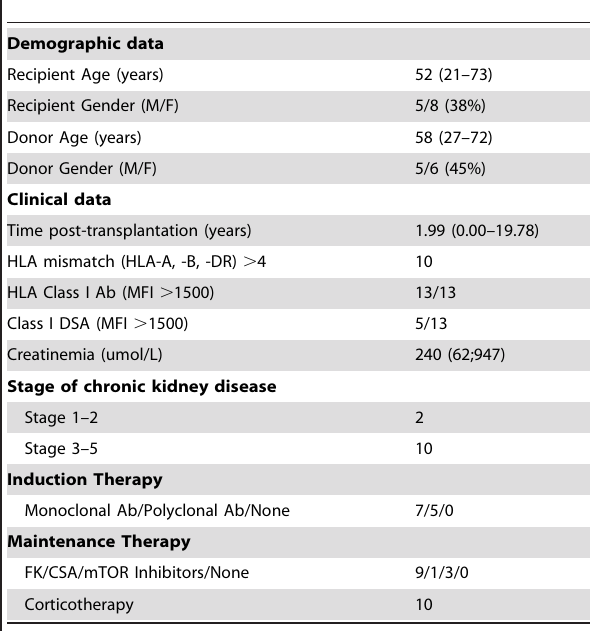
Table 2. Summary of demographic and clinical characteristics of patients analyzed using single HLA class I antigen coated